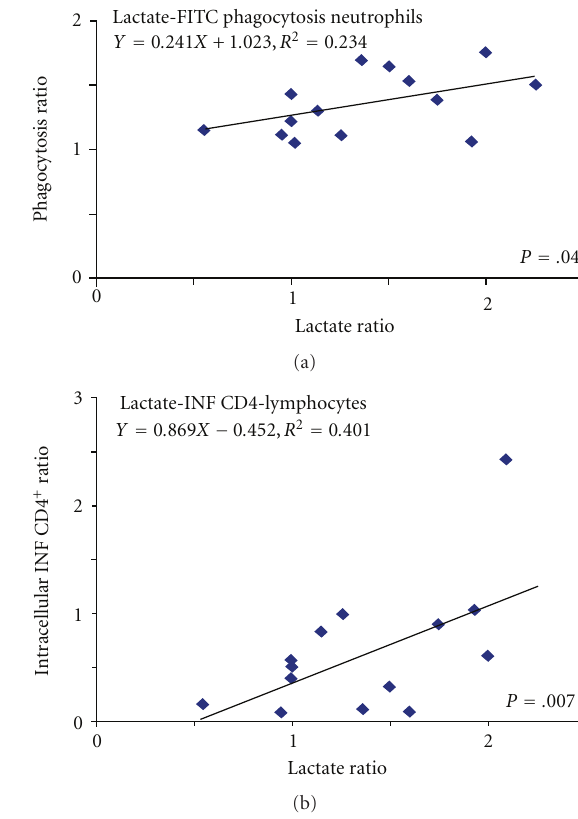
Figure 7: Correlation analysis determined a linear regression between (a) the lactate hypoxia/lactate normoxia ratio and the phagocytosis hypoxia/phagocytosis normoxia ratio in neutrophils, (b) the lactate hypoxia/lactate normoxia ratio and the intracellular INF hypoxia/intracellular INF normoxia ratio in CD4 + T lympho-